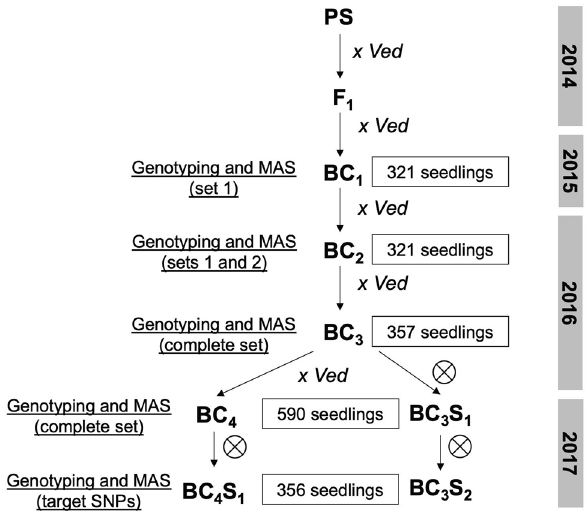
Figure 1. Breeding scheme followed to develop the IL